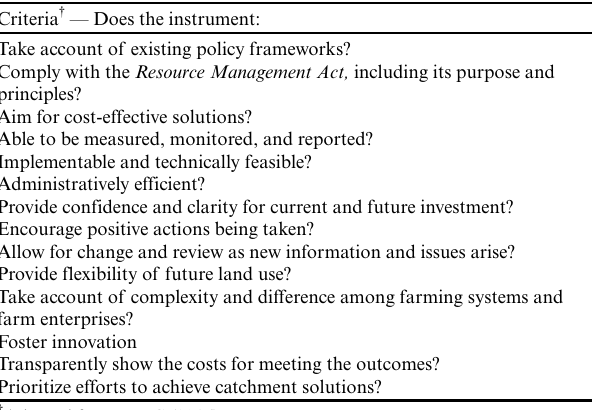
Table 2. Illustrative criteria for choosing an instrument to change resource use.